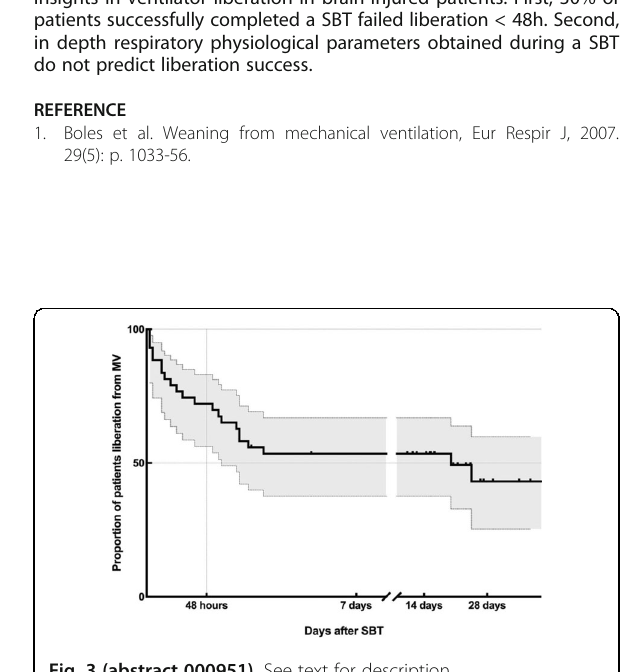
Fig. 3 (abstract 000951). See text for